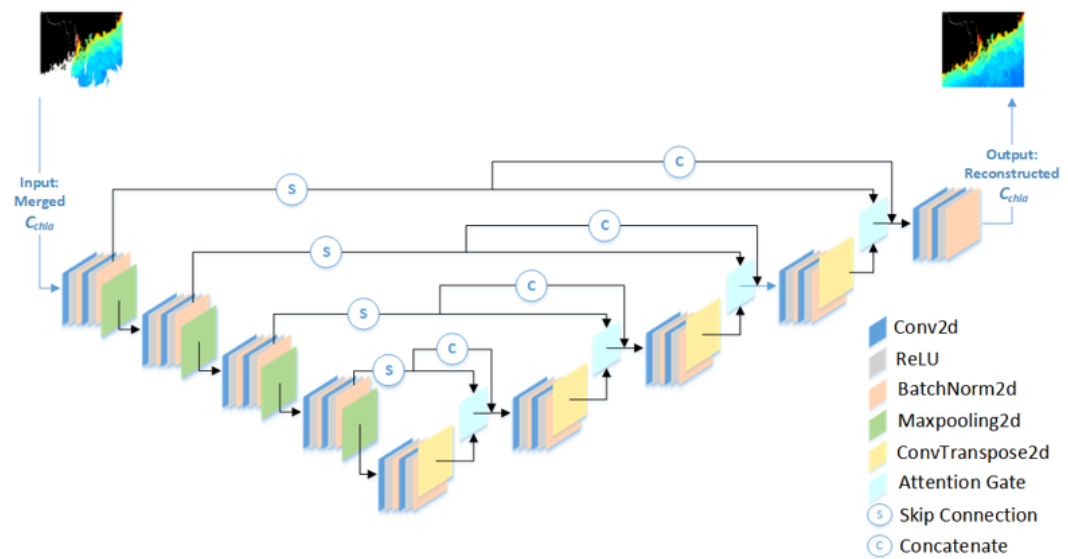
Figure 2. A block diagram of the proposed Attention U-Net model.